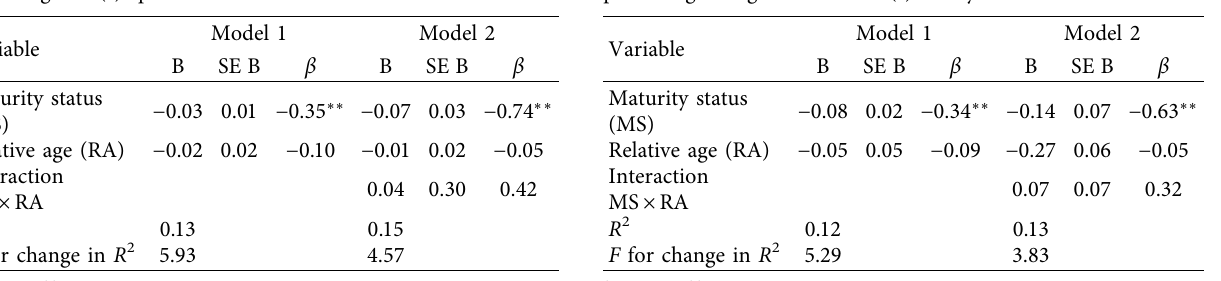
Table 3: Summary of hierarchical regression analysis for variables predicting 5 m (s) sprint time.